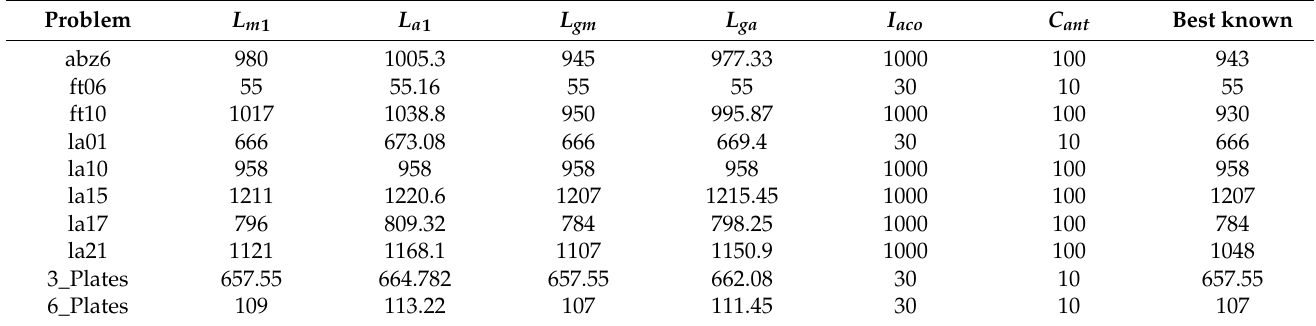
Table 3. Comparison of